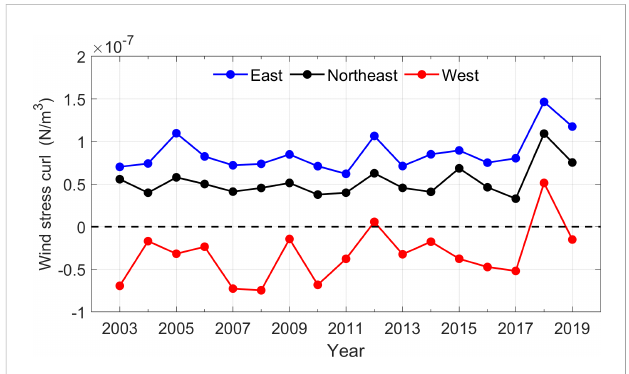
FIGURE 6 Interannual variation of sea surface wind stress curl in three upwelling